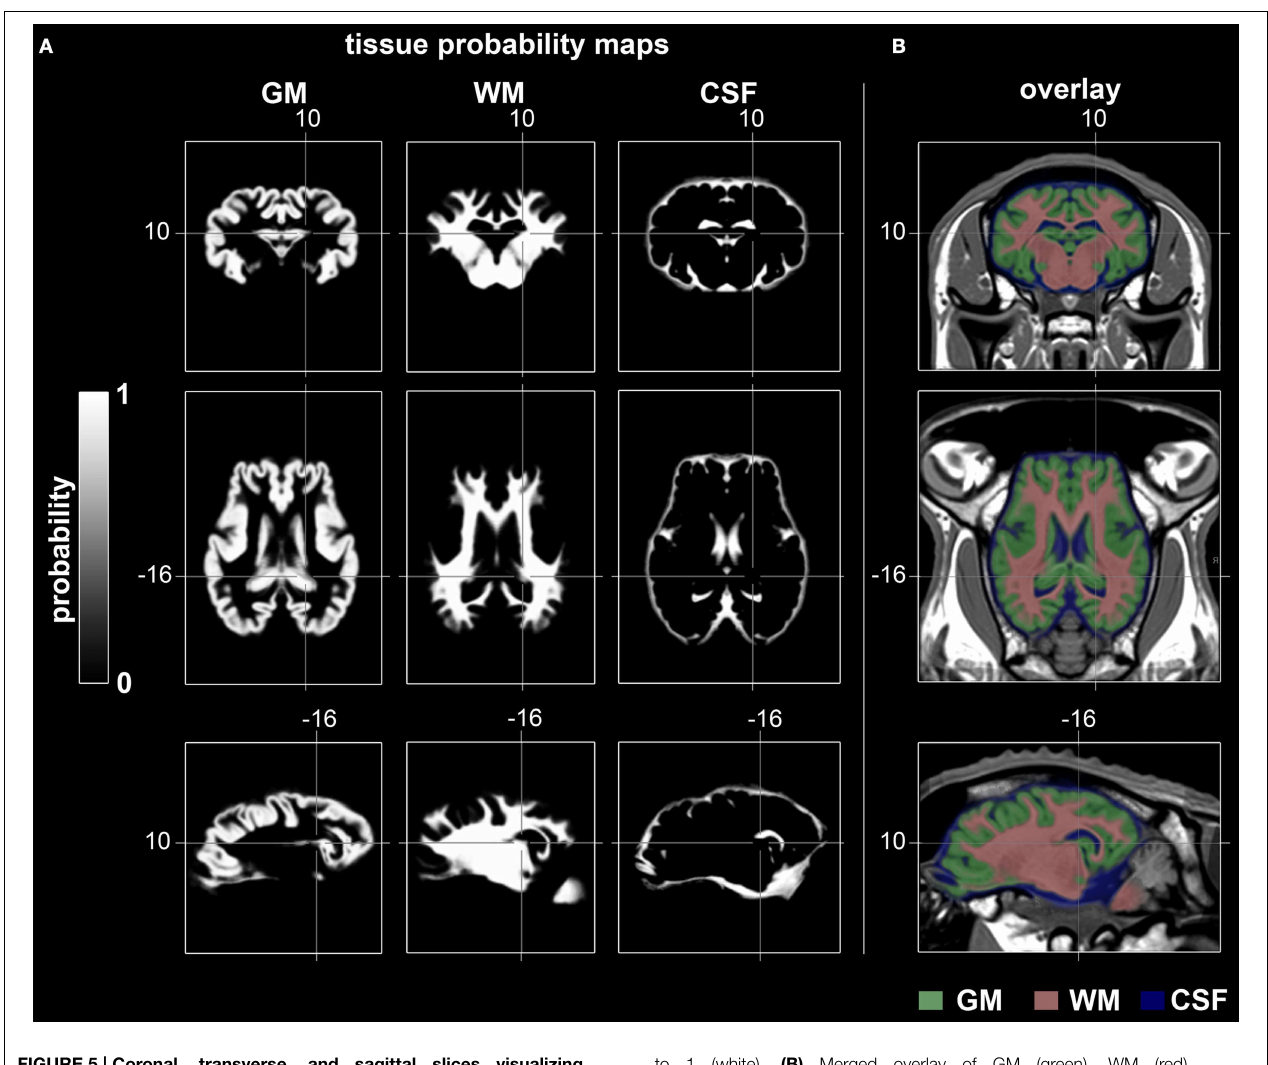
to 1 (white). (B) Merged overlay of GM (green), WM (red), and CSF (blue) TPM with the template. Stereotaxic coordinates are given in mm. GM, gray matter; WM, white matter; CSF, cerebrospinal